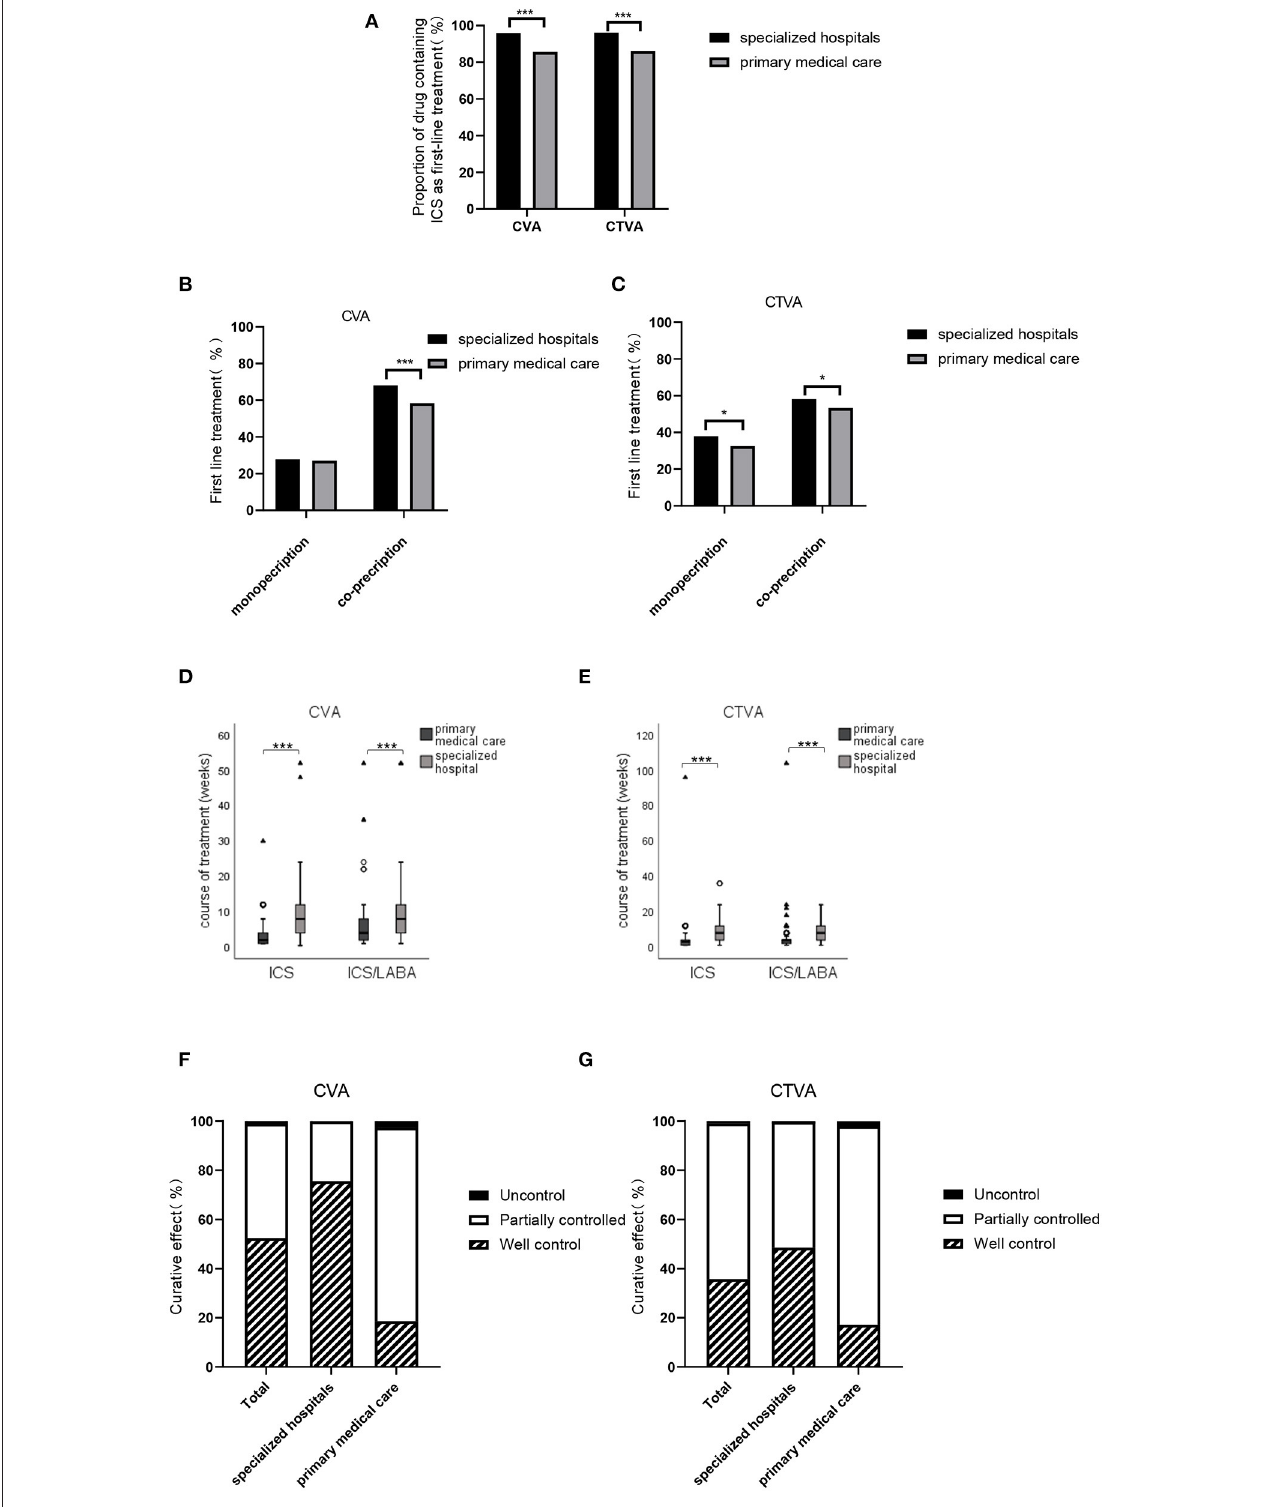
FIGURE 3 | Medications prescribed for CVA and CTVA. (A) Proportion of physicians who prescribed an ICS as a first-line treatment for patients with CVA or CTVA in specialized hospitals and primary medical care facilities. (B) Proportion of physicians who prescribed an ICS or ICS + LABA as monotherapy or combined with